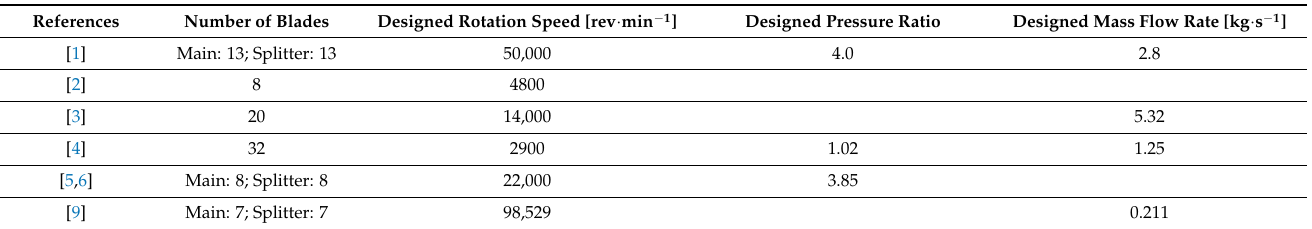
Table 1. Operating conditions and structural parameters of the compressors in references.